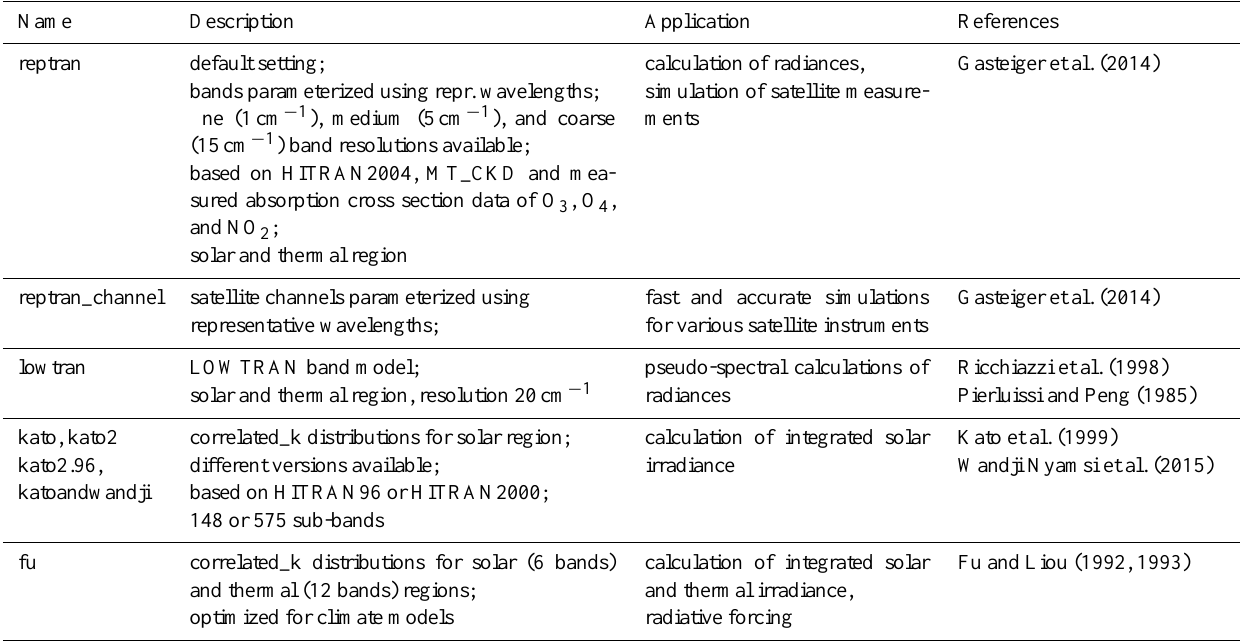
Table 2. Absorption parameterizations in